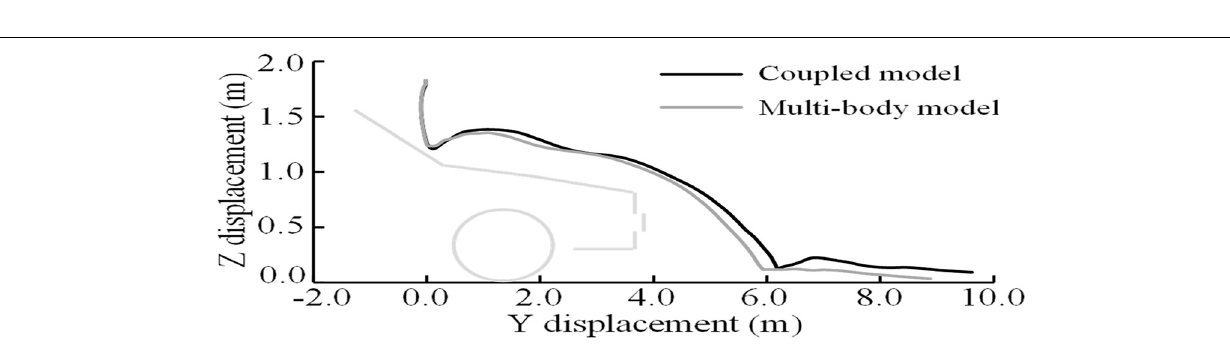
FIGURE 9 | Comparison of the trajectory of VRU head COG in the YOZ plane in Case 1 between using MB and coupled FE–MB models. VRU, vulnerable road user; COG, center of gravity; MB, multibody; FE, finite